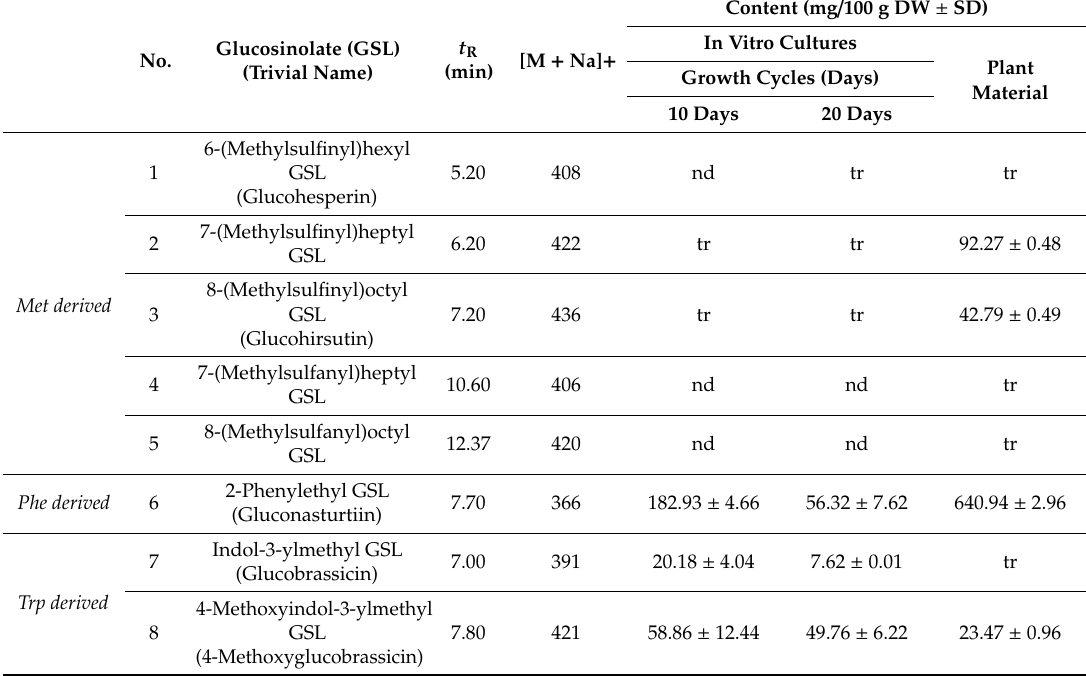
Table 2. GSLs profile and quantitative content of detected compounds in N. o ffi cinale extracts from bioreactor microshoot cultures and the herb of the parent plant confirmed by UHPLC-DAD-MS /